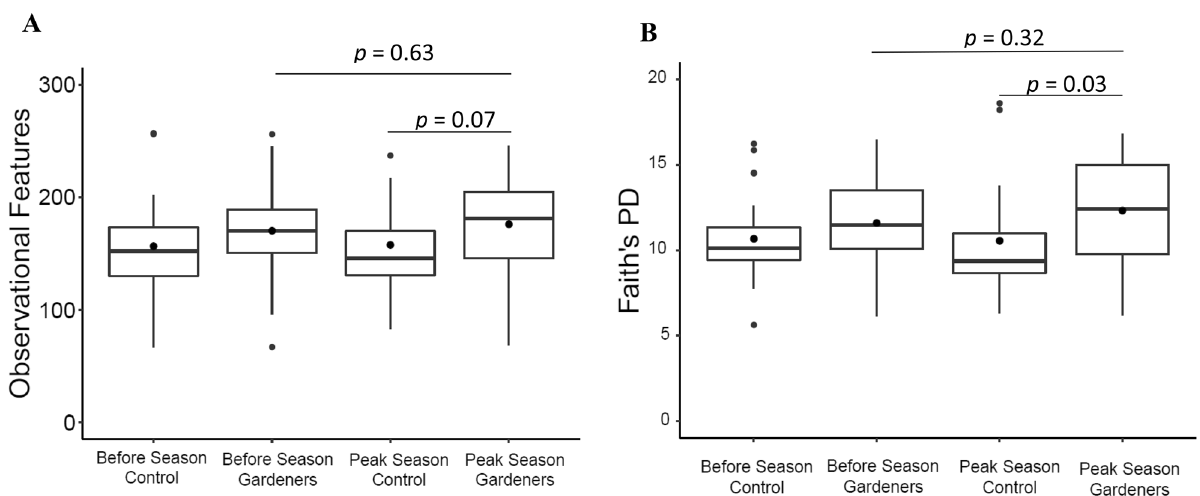
Figure 2. Comparisons of alpha diversity metrics including ( A ) Operational Features and ( B ) Faith’s Phylogenic Diversity between all participants across the gardening season. Kruskal–Wallis pairwise statistics were used to test